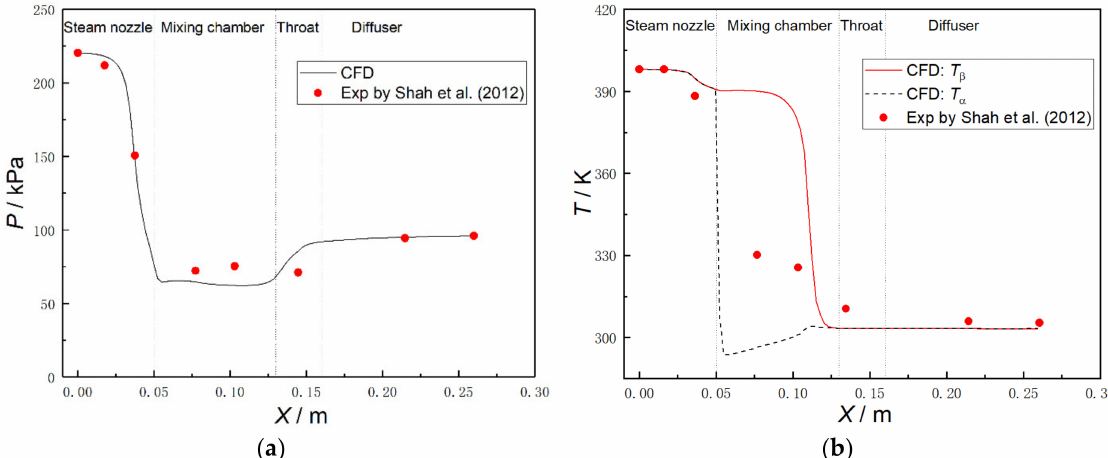
Figure 4. Comparison of axial static pressure and temperature profiles between numerical result and experimental data, m β 1 = 0.0102 kg/s, T β 1 = 398 K, m α 1 = 0.49 kg/s, T α 1 = 290 K, P out = 96 kPa. ( a ) axial static pressure profile; ( b ) axial temperature